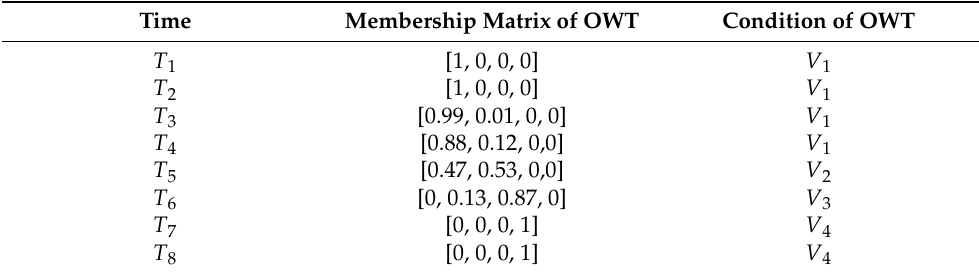
Table 2. Results of